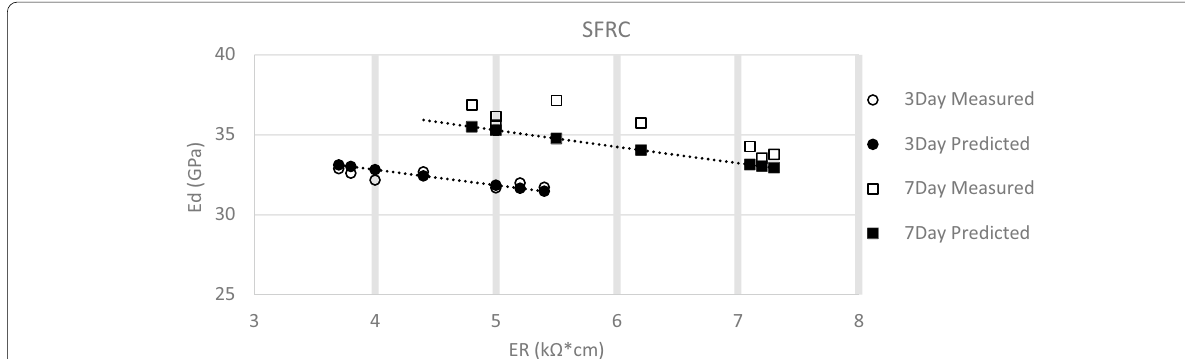
Fig. 7 Correlation between dynamic modulus and electrical resistivity for SFRC.